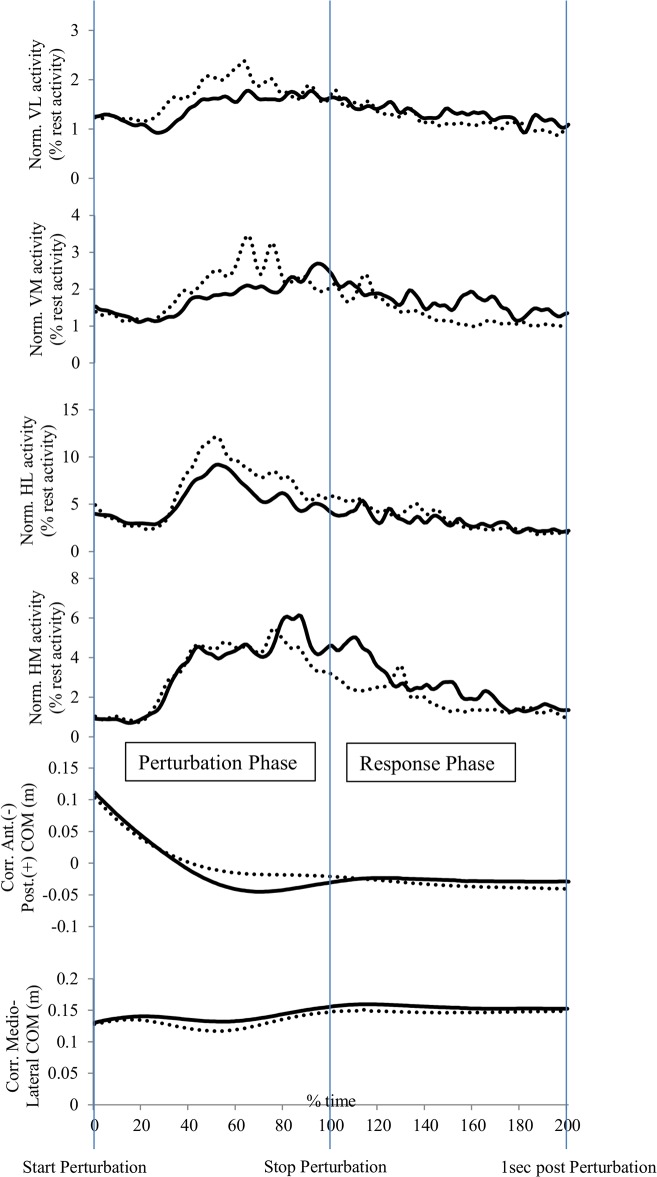
Data of all 13 participants to illustrate the different time periods.The straight line represents the average data for the large multi-planar perturbation (MMP-L) and the dotted line represents the average data for the large single-planar perturbation (SPP-L).